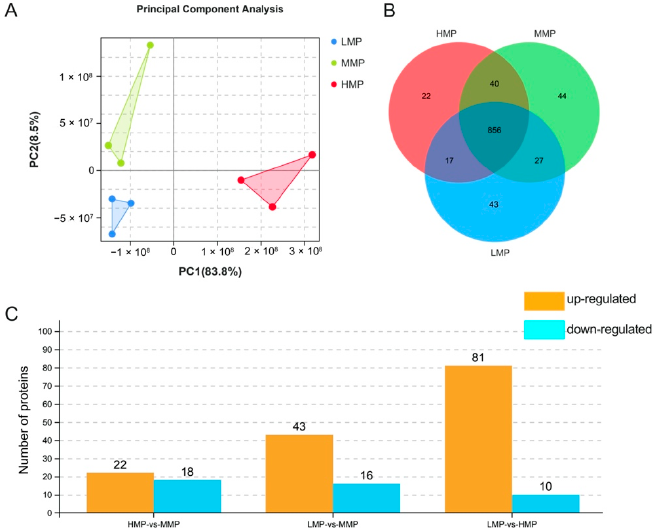
Figure 2. PCA and characteristics of plasma proteome among three groups. ( A ) PCA analysis of plasma. ( B ) Plasma proteins identified in three groups of cows. ( C ) Number of differential proteins identified in the plasma of three groups of cows. LMP: low milk protein concentration group; MMP: medium milk protein concentration group; HMP: high milk protein concentration group. The group presented before the symbol “vs” was a control group.